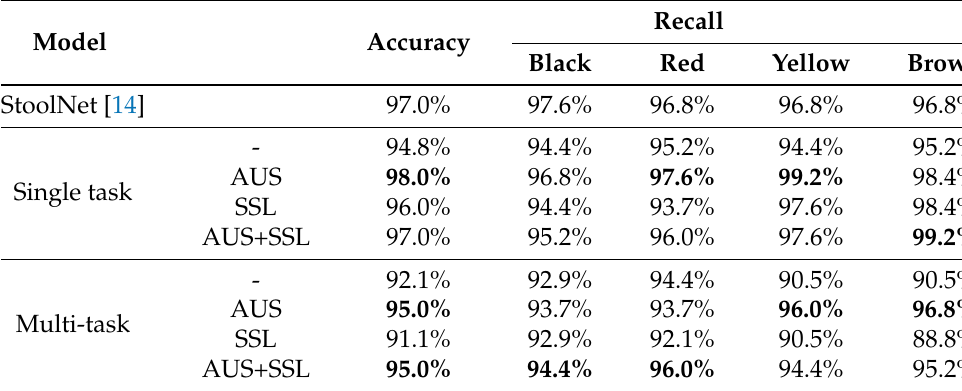
Table 3. Results for four color categories in medical